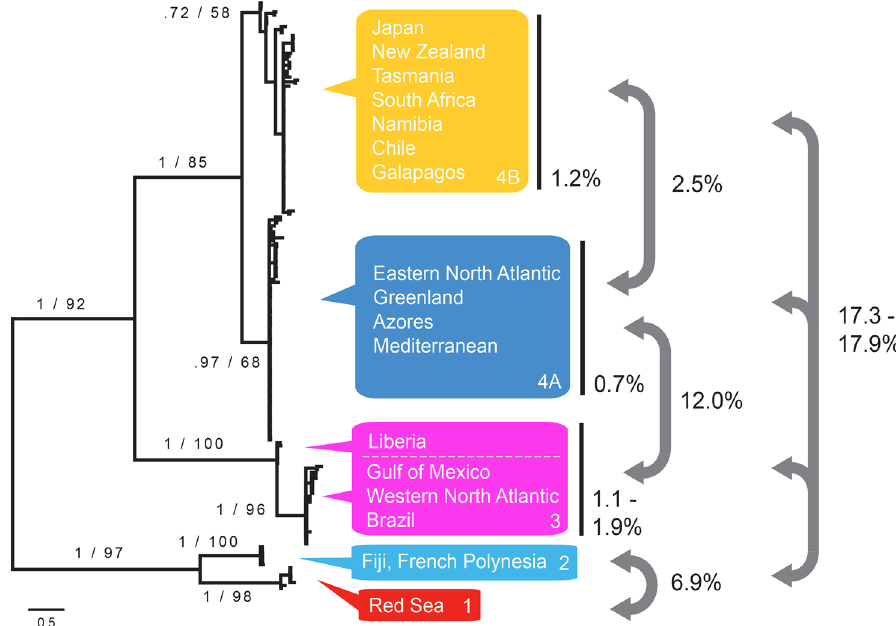
Figure 2. Bayesian phylogeny based on COI data (full 198 sample dataset). Bayesian posterior probabilities and ML bootstrap support values (from ML analysis of 157 Maurolicus sequences) are indicated for the various clades. Geographical locations of specimens within clades are shown together with maximum p-distances next to white bars (minimum and maximum p-distances are shown for eastern Equatorial vs. western Atlantic / Gulf of Mexico). Relationships among groups are shown by mean between-group